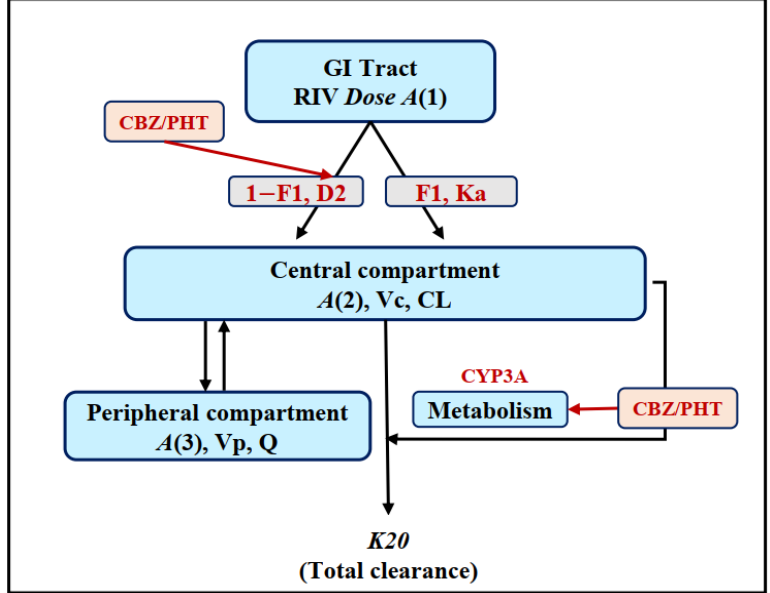
Figure 1. Schematic representation of the base population pharmacokinetic model for rivaroxaban (RIV) and strategies to investigate the e ff ect of carbamazepine or phenytoin (CBZ / PHT) on the pharmokinetics (PK) of RIV. All notations are mentioned in the